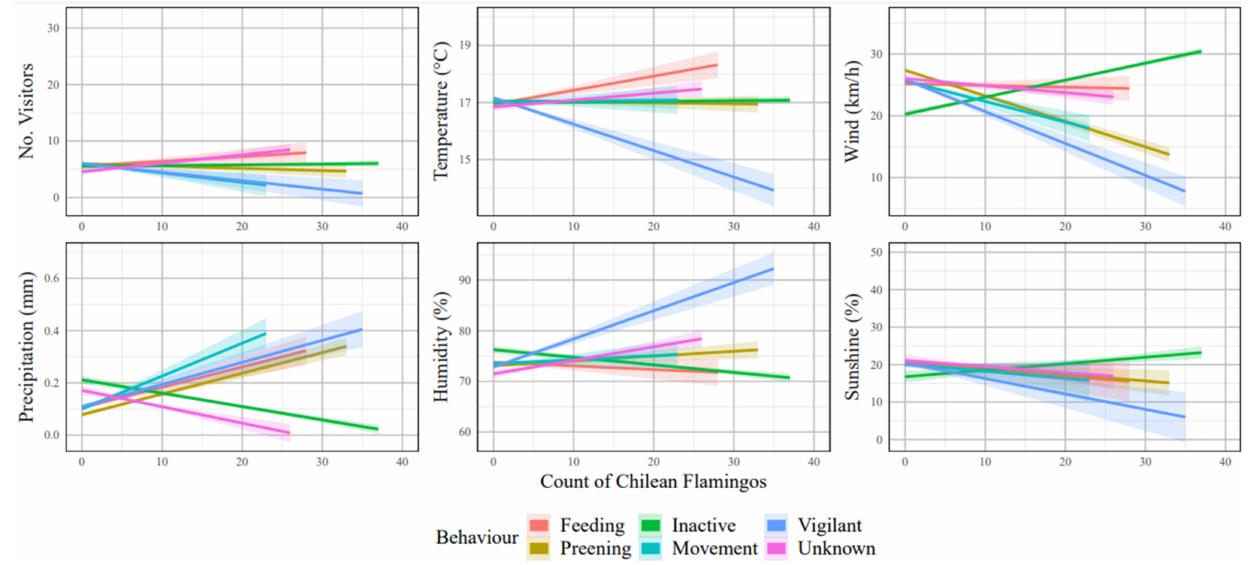
Figure 5. Correlation between counts of key behaviours performed by the Chilean Flamingo flock during the zoo-reopen condition and environmental factors. Shaded areas around lines represent ± 95% CI. Number of visitors showed a weak negative correlation with vigilance. Weak significant correlations (0.1 ≤ r s ≤ 0.29) also held between: temperature-feeding, vigilance; wind-movement; precipitation-feeding, movement, vigilance, unknown; humidity-inactivity, vigilance. Significant moderate correlation (0.3 ≤ r s ≤ 0.49) was shown between: wind-preening, inactivity, vigilance; precipitation-preening,